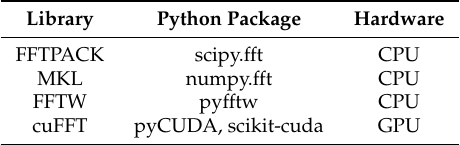
Table 3. Selected libraries and corresponding Python